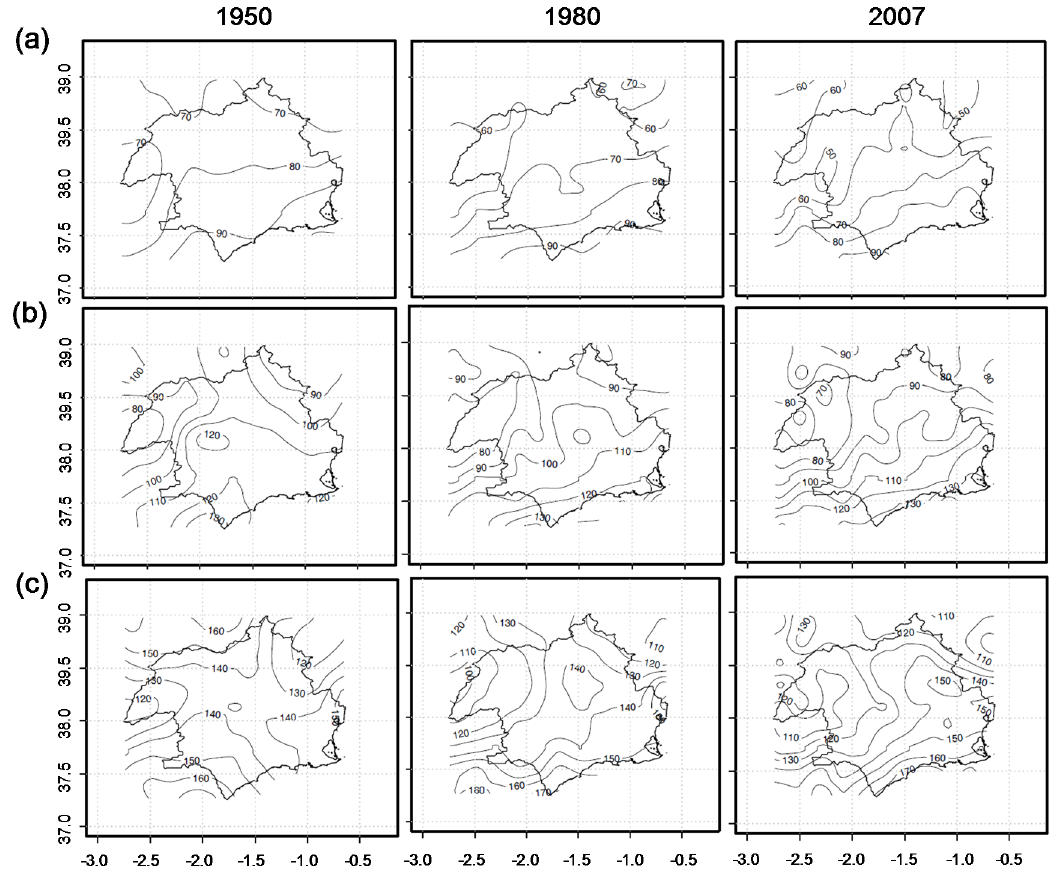
Figure 5. Spatial distribution of μ (days) of MDSL, for years 1950, 1980, and 2007, considering several thresholds for Tr = 2 years: ( a ) 1 mm/day; ( b ) 5 mm/day; ( c ) 10 mm/day.